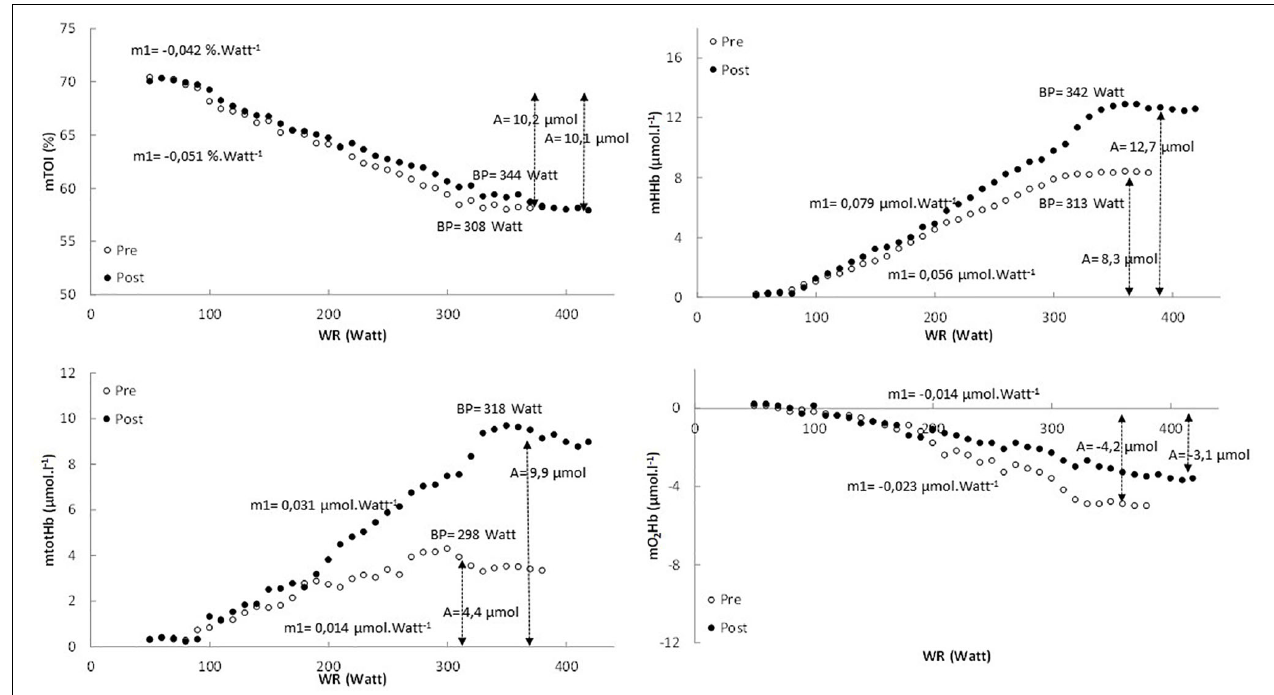
FIGURE 1 | The pattern of mTOI, mHHb, mtotHb, and mO 2 Hb expressed as a function of power output for the pretest (white dots) and posttest (black dots) in a representative subject.